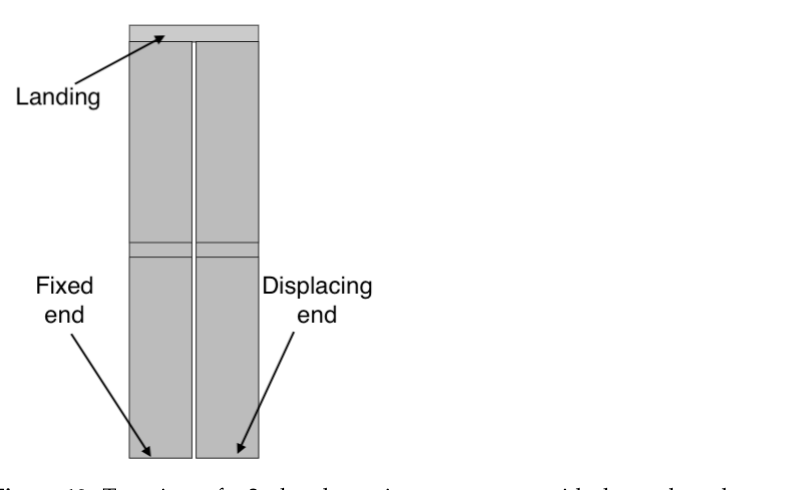
Figure 10. Top view of a 2nd-order staircase actuator, with the anchored actuator on the left, the connecting landing at the top, and the second actuator on the